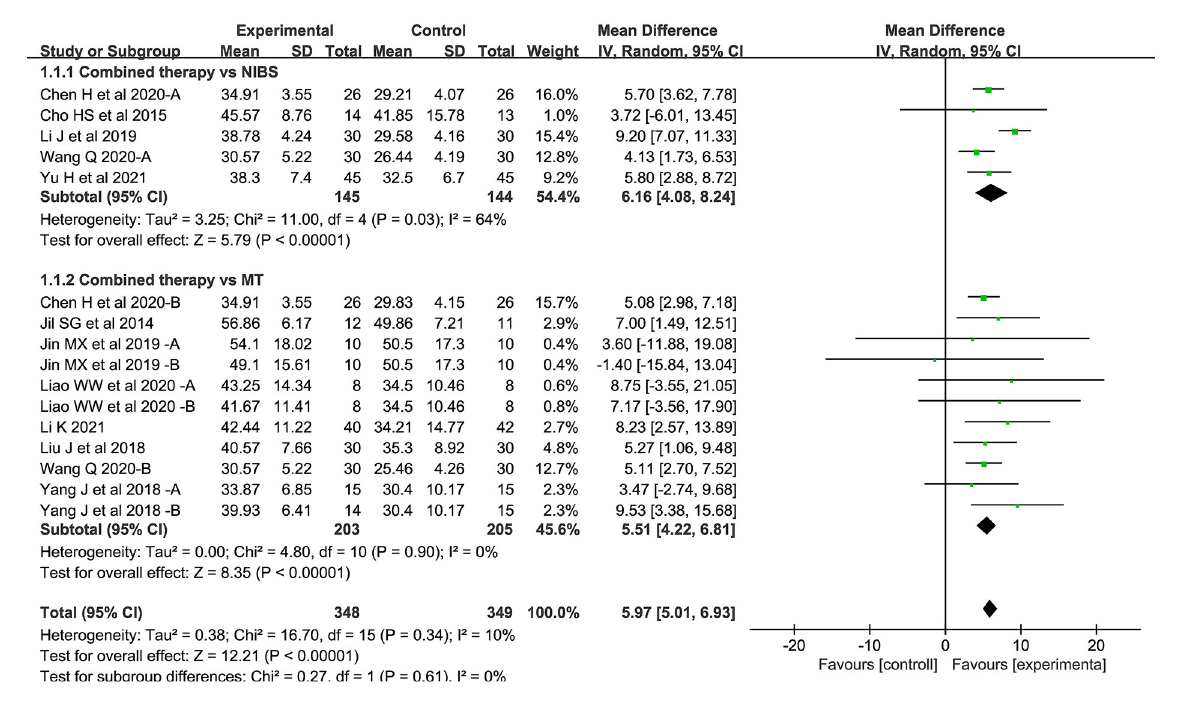
FIGURE3 Forest plot of trails comparing NIBS combined with MT vs. NIBS or MT alone for body structure/functional domains.